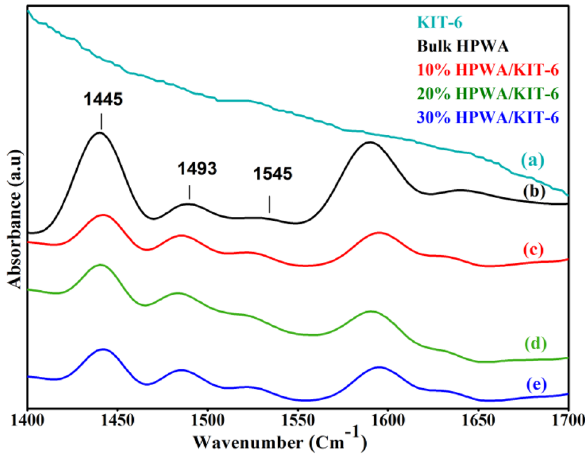
-TPD spectrum of 10% HPWA/ 3